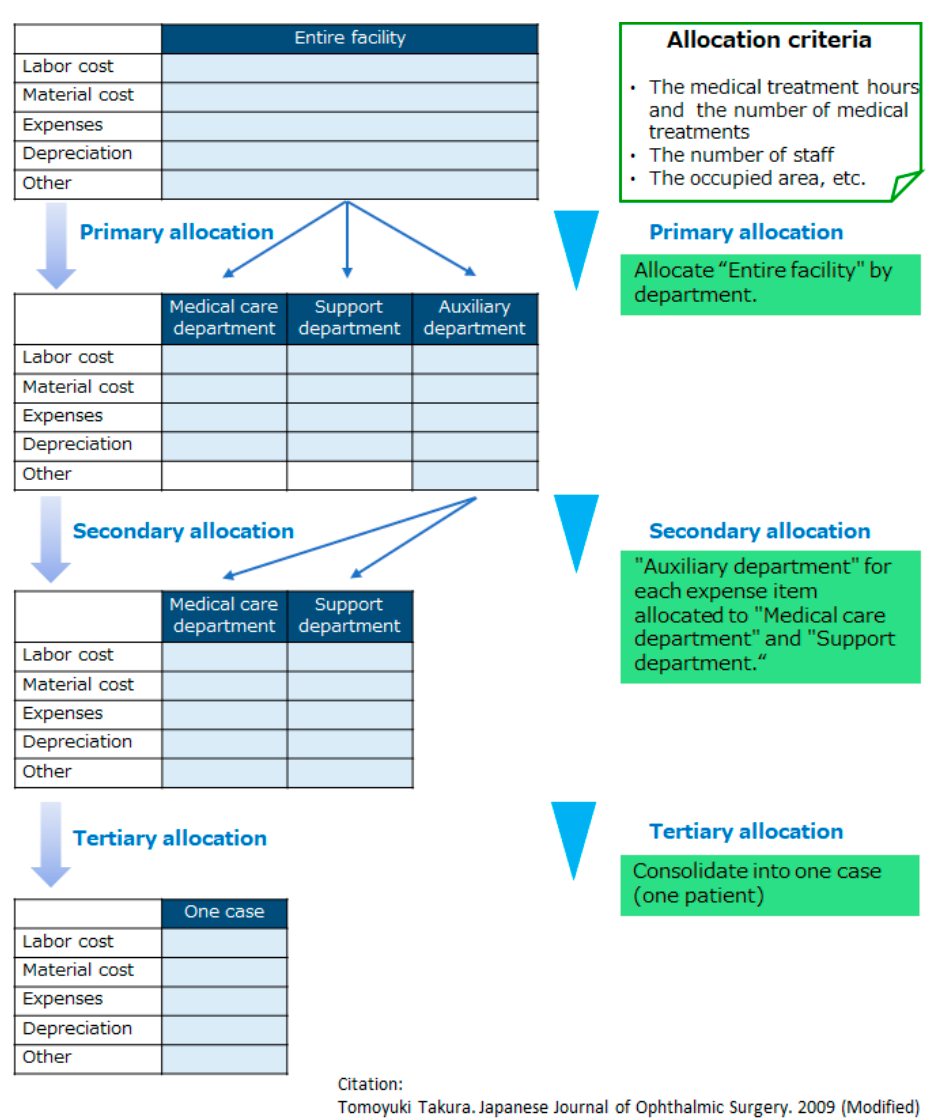
Figure 2. Cost of the entire facility apportioned to one case in three stages (calculation frame of medical expenses) .